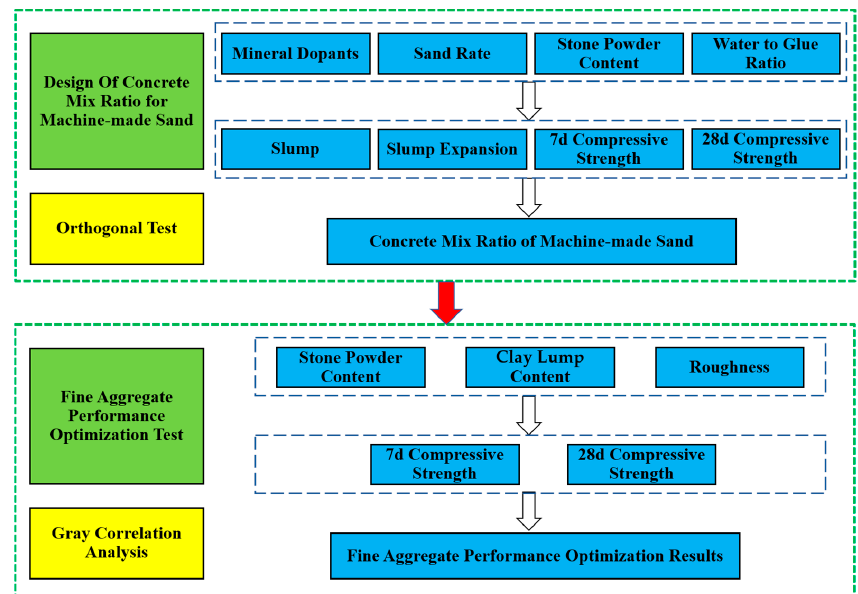
Figure 2. Flow chart of this study.